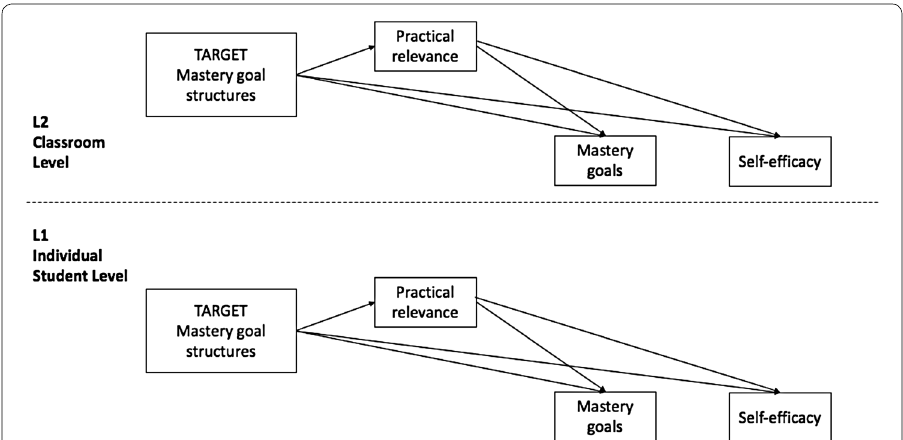
Fig. 1 Multilevel predictive model: Statistical model for investigating relations between mastery goal structures, mastery goals, and self-efficacy, and mediating effects of practical relevance on the individual student and the classroom level in each